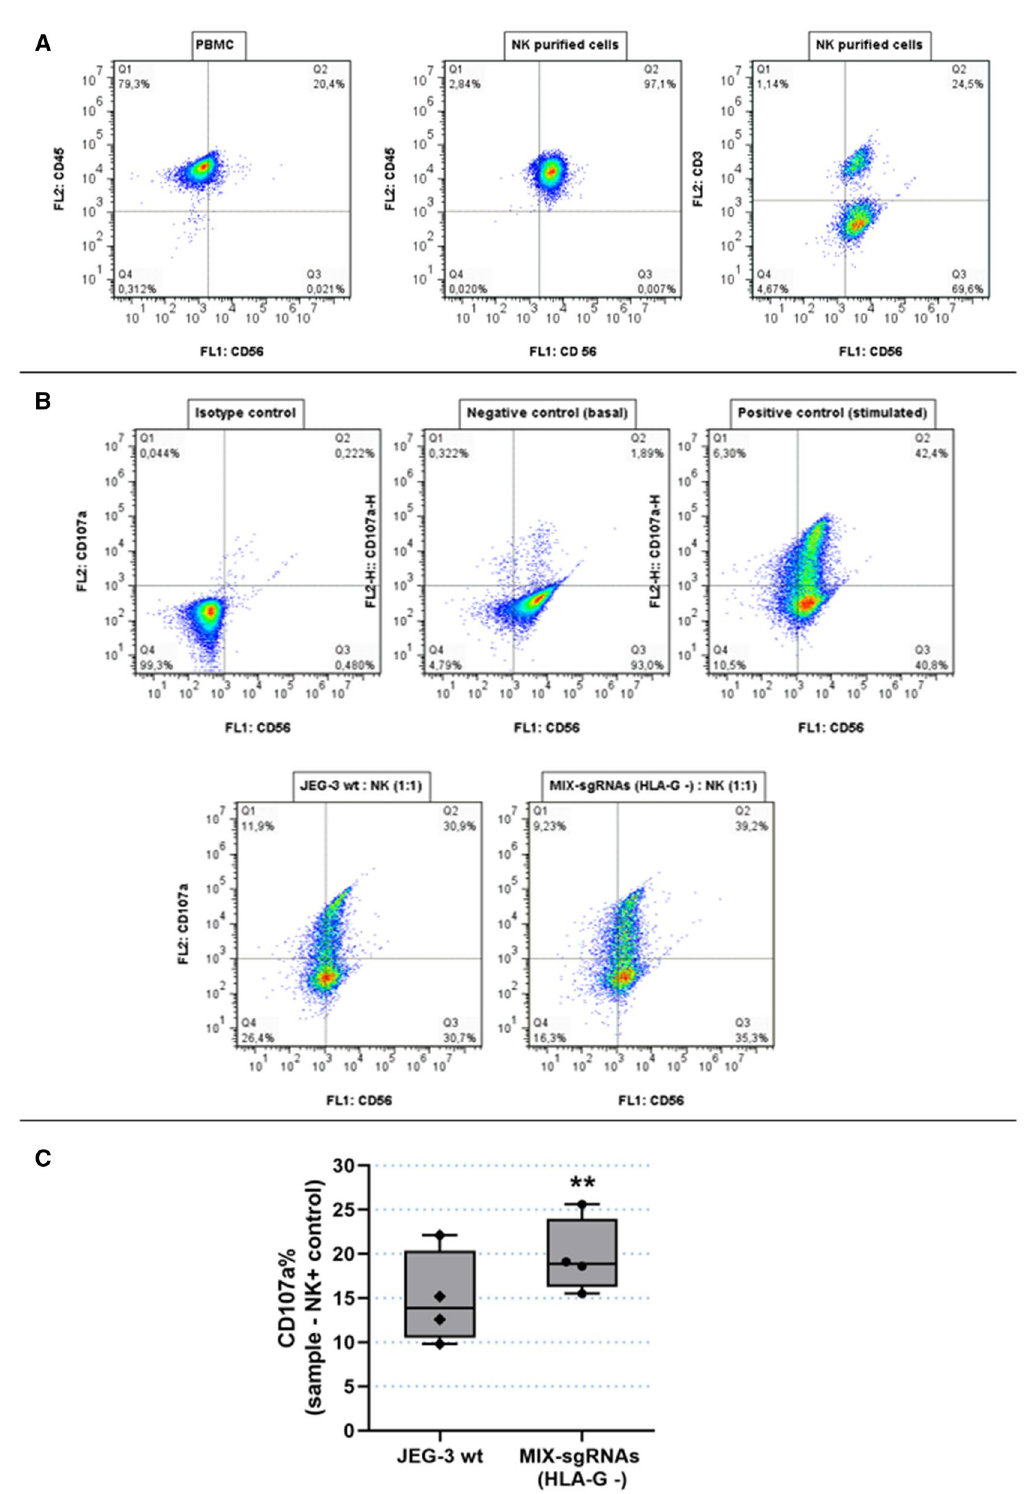
Figure 6. Degranulation assay, functional analysis of HLA-G wt and HLA-G − JEG-3 cells. ( A ) Determination of NK cells purification. NK cells were stained with anti-CD45/PE, anti-CD56/BB515 and anti-CD3/PE and compared with PBMC. ( B ) As a representative assay, NKs were labelled with CD107a/PE and CD56-BB515. The conditions were the following: Isotype control (NK without Ab), negative control (NK basal degranulation), positive control (stimulated NK cells) and NKs co-cultured with wt JEG-3 or with JEG-3/MIX-sgRNAs (HLA-G −). ( C ) Box plots show the percentage of CD107a + NK cells when co-cultured with wt JEG-3 (HLA-G wt) or with JEG-3/MIX-sgRNAs (HLA-G −). Significant differences are shown with * ( p < 0.05) (n = 4